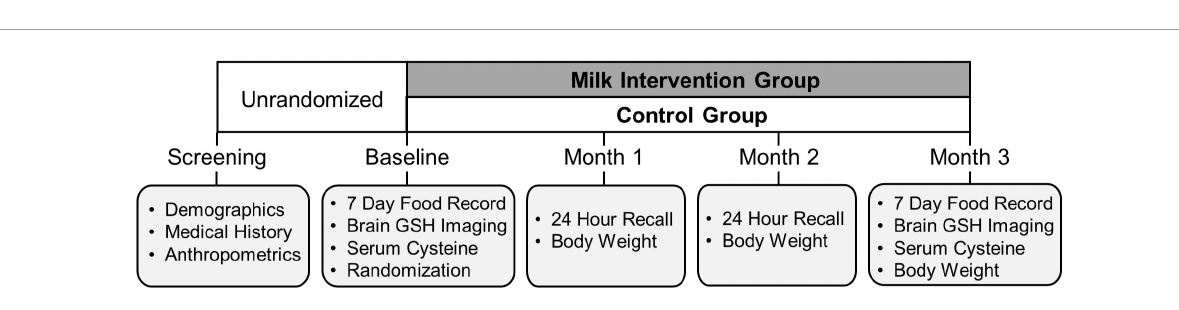
FIGURE2 Timeline of the data collection of in-person MILK study